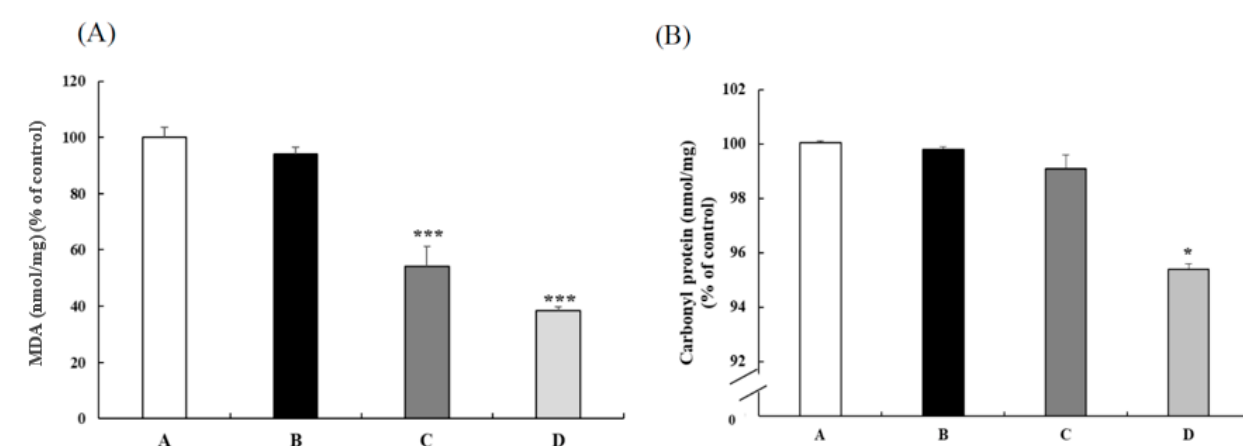
Figure 1. The (A) MDA and (B) carbonyl protein levels in the livers of 3-month-old male SAMP8 mice fed with different diets for 12 weeks. Values are displayed as mean ± S.E.M. and were analyzed by one-way ANOVA ( n = 6/group). * p < 0.05, *** p < 0.001 compared to the control group. A = SAMP8 control, B= 50 mg/kg BW/day CB, C = 100 mg/kg BW/day CB, D = 200 mg/kg BW/day CB.